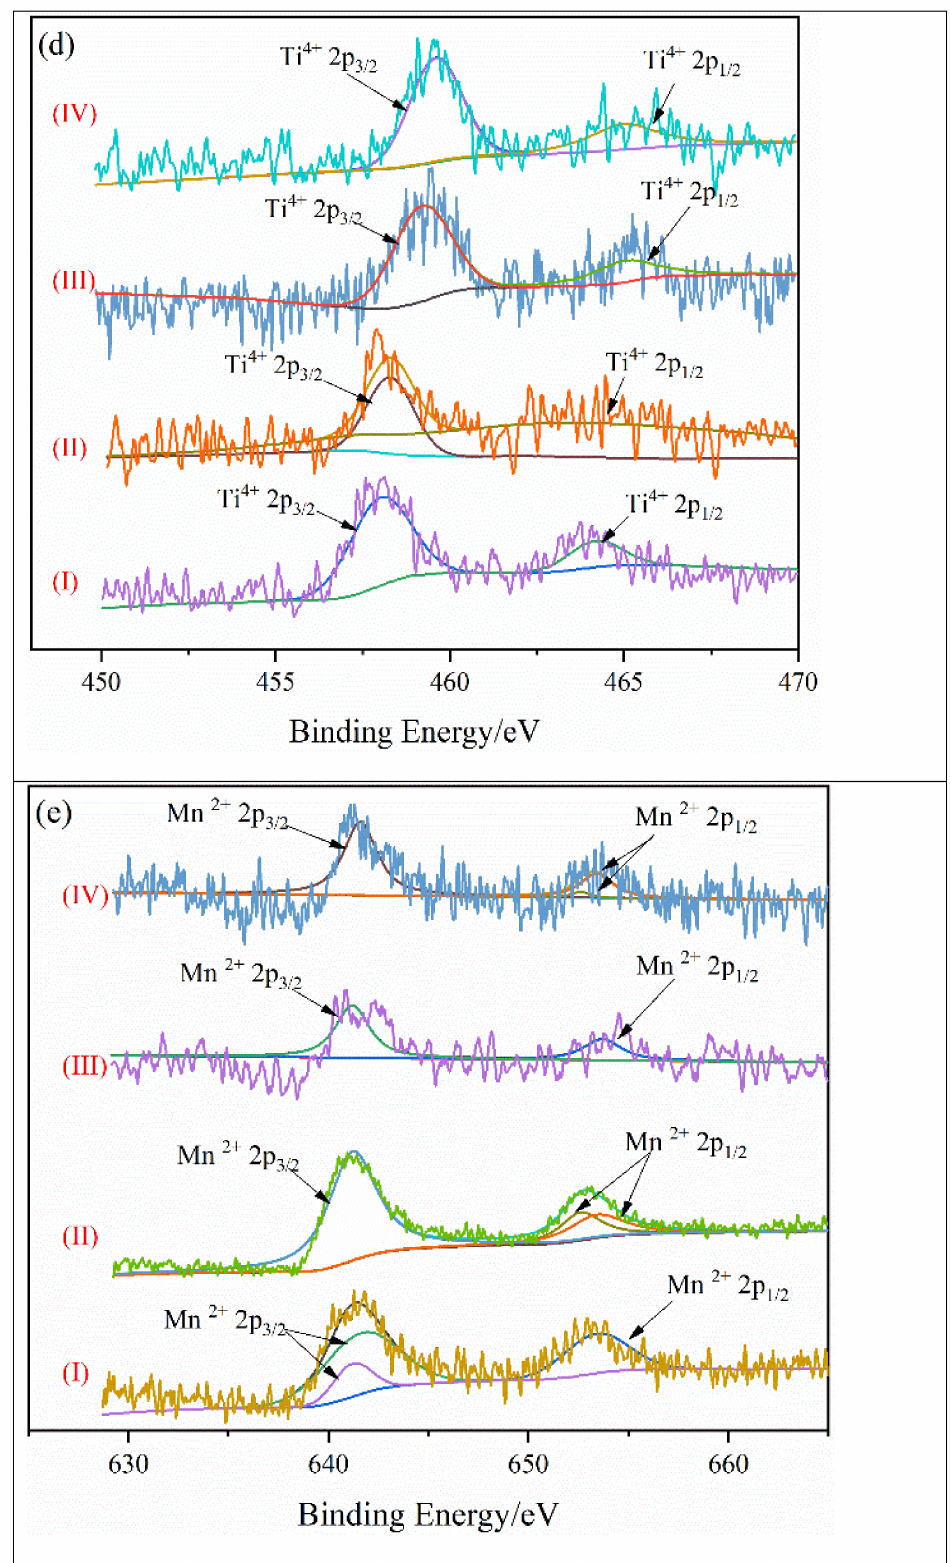
Figure 5. XPS analysis of the slag ( a ) Full spectrum, ( b ) Fe spectrum, ( c ) V spectrum, ( d ) Ti spectrum and ( e ) Mn